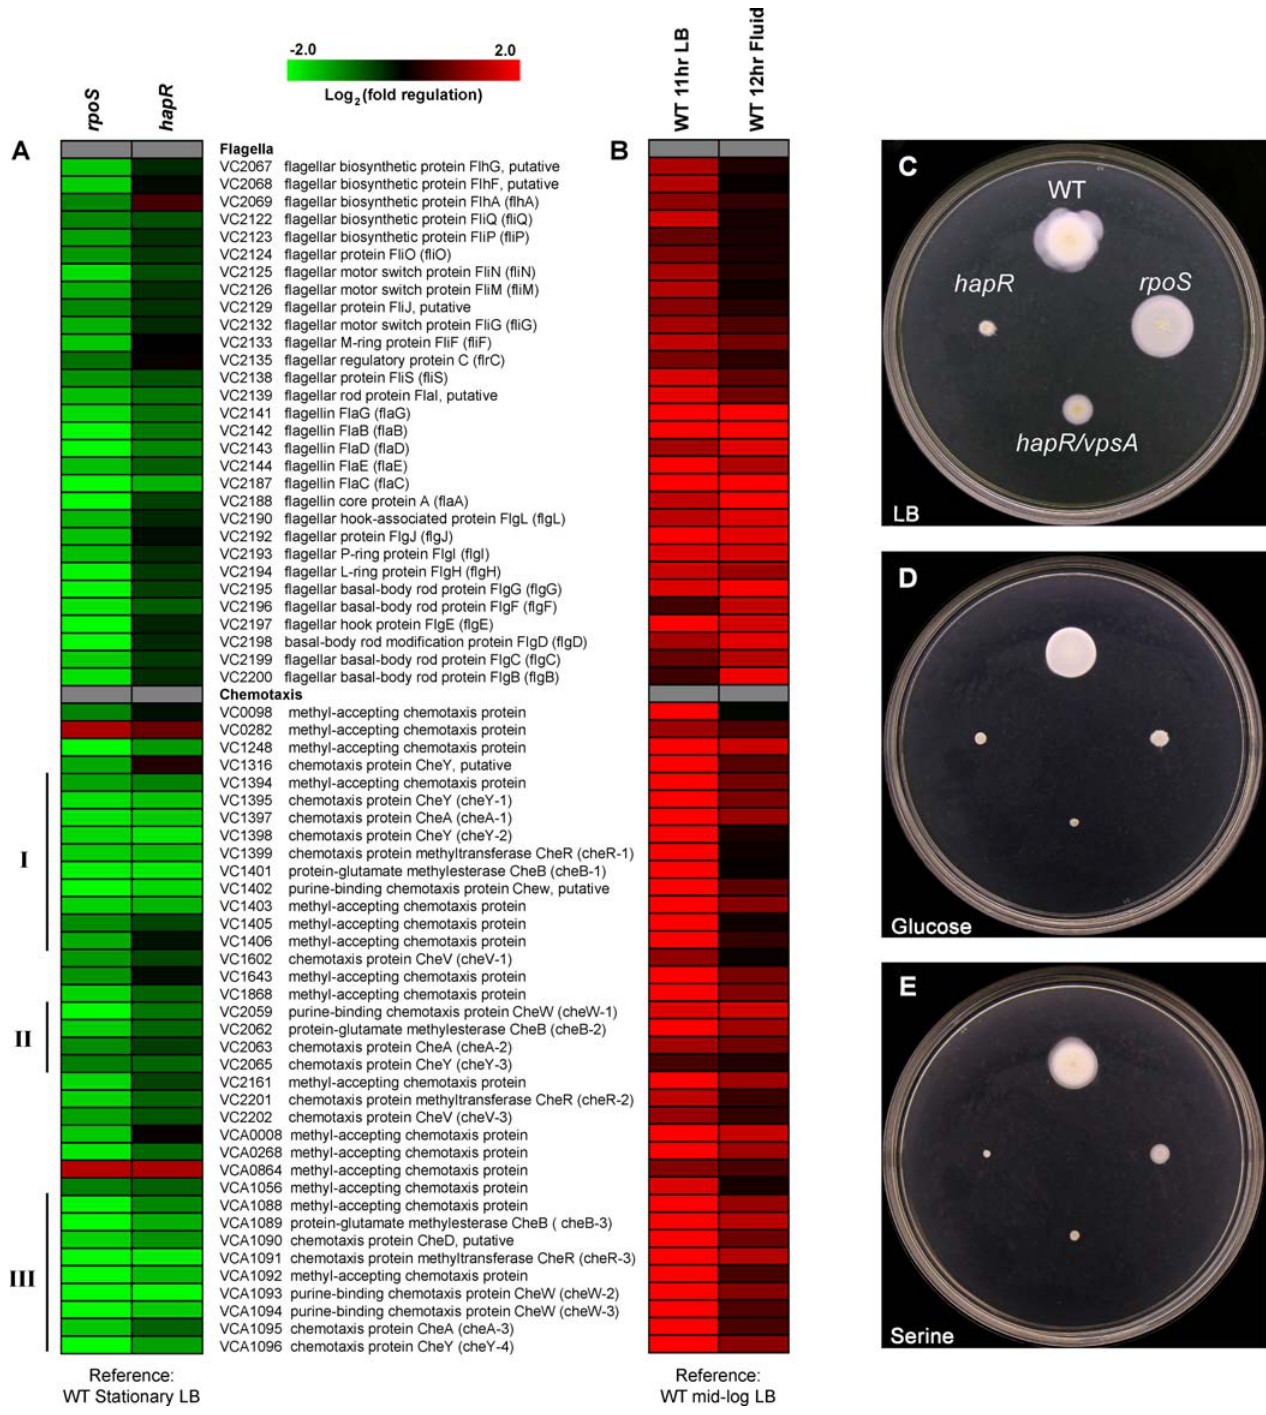
Figure 3. RpoS and HapR Are Required for the Regulation of Chemotaxis and Motility Genes in Stationary Phase (A) Gene expression of V. cholerae, rpoS, and hapR deletion mutants in stationary phase LB cultures was analyzed and compared to the wild-type parent under identical conditions. Only chemotaxis and motility-annotated genes with at least a 2-fold statistically significant change in the rpoS mutant are shown (except for flrC, which was induced 1.9-fold with statistical significance). Genes requiring RpoS or HapR for their induction are identified with green colors. The three genomic chemotaxis clusters are marked and numbered to the left of the cluster. (B) Gene expression of the wild-type parent during stationary phase after 11 h growth in LB was analyzed using RNA from an exponentially growing culture as a reference. The expression of these genes is compared with the expression of genes from bacteria isolated from luminal fluid after 12 h of infection of rabbit ileal loops using the same mid-exponential phase reference. Genes induced under these conditions are identified with a red color. (C–E) The motility of the wild-type parent was compared with the mutants by spotting wild-type V. cholerae (top), hapR (left), rpoS (right), and hapR/ vpsA (bottom) on low-percentage agar plates formulated with either LB (C), glucose (D), or serine (E) as the only carbon source. The plates were incubated at 37 8 C for 24–48 h. DOI: